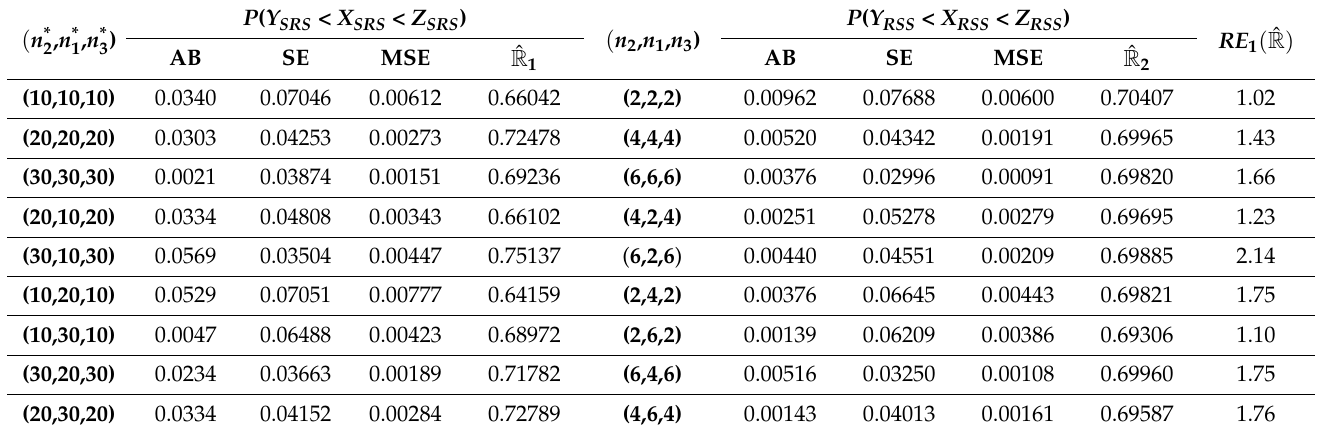
Table 7. Measurements of ˆ R 1 and ˆ R 2 for sampling schemes at R = 0.694 and d = 5.